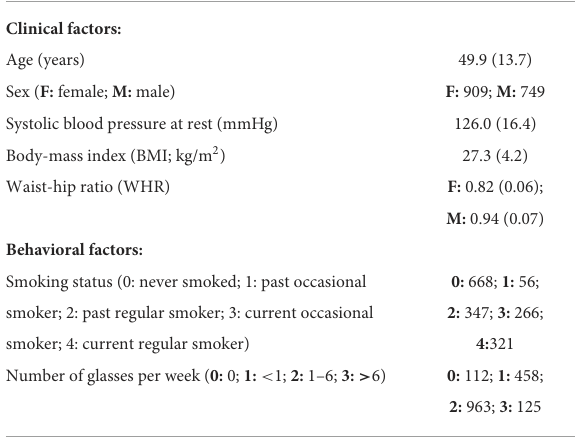
TABLE 1 Demographic and cardiovascular risk factor information of the participants included in the